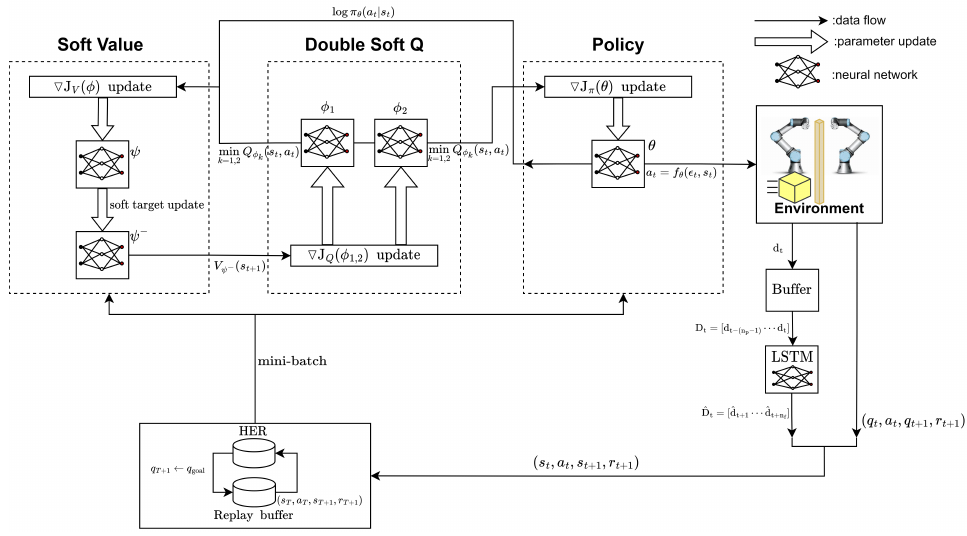
Figure 3. Architecture of the proposed SAC-based path planning algorithm with